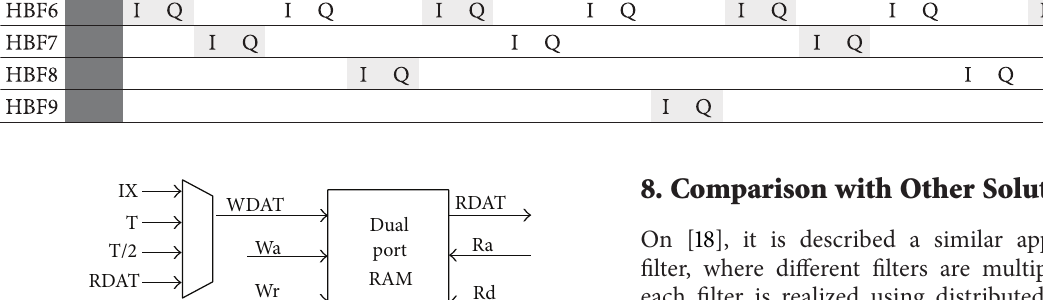
the enable for the registers, and the selection signals for the multiplexers. It is synchronized by a pulse coming from the rotator